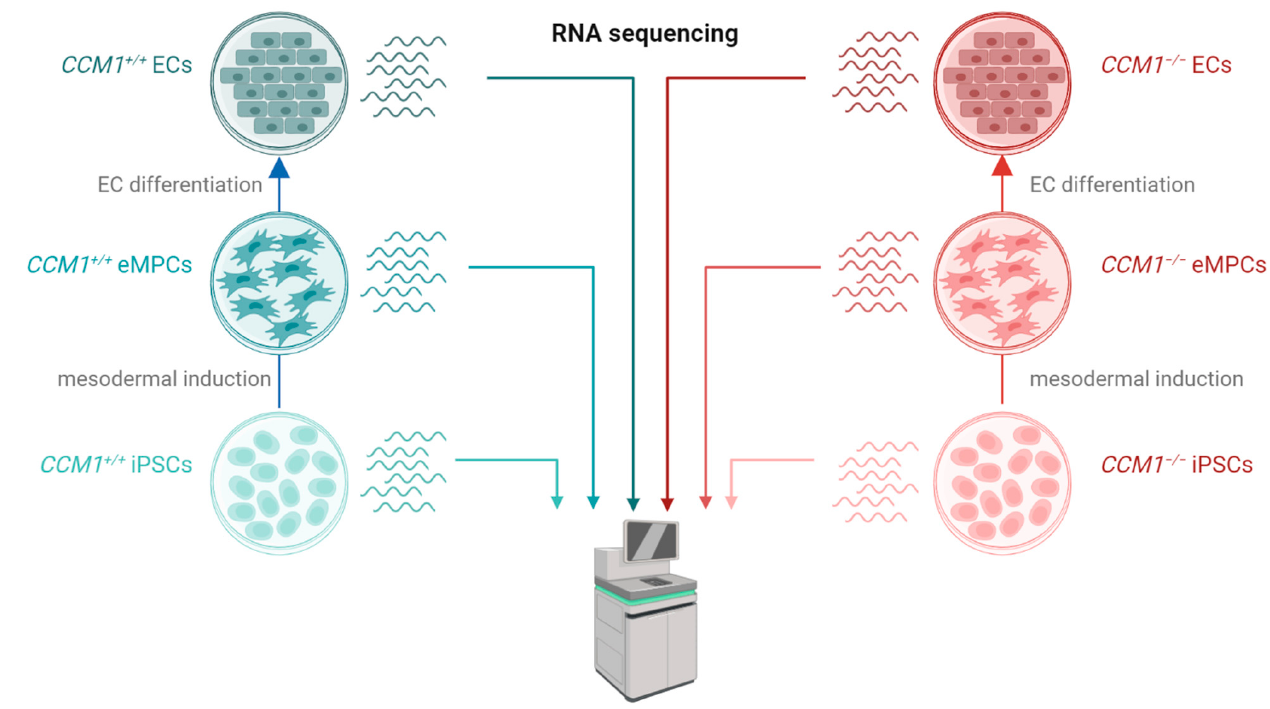
Figure 1. Experimental design of the study. CCM1 +/+ (blue) and CCM1 − / − (red) induced pluripotent stem cells (iPSCs) were differentiated into early mesoderm progenitor cells (eMPCs) and endothelial-like cells (ECs). RNA sequencing was used to study gene expression differences.